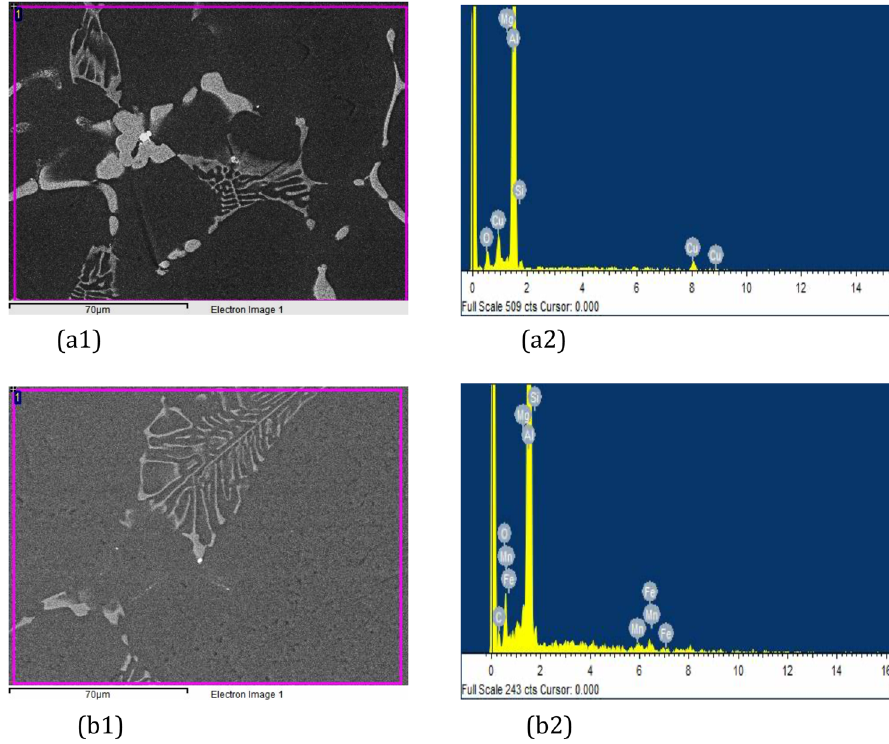
Figure 2: SEM micrographs and EDS analysis pro fi les of ( a ) Al – 8 wt% CuZnAlNi and ( b ) Al – 8 wt% SiC.